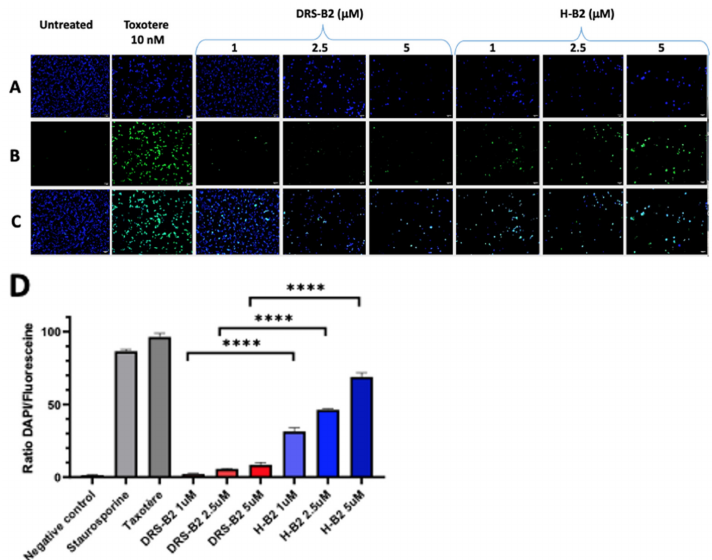
Figure 10. Terminal transferase-mediated dUTP nick end-labeling (TUNEL) in vitro assay of treated PC3 cells. Apoptosis of PC3 cells using TUNEL assay in vitro after DRS-B2 and H-B2 treatment. Cells were treated for 24 h with increasing concentrations of each peptide. Taxotere treatment was performed as a positive control for apoptosis. ( A ) Cells were stained with DAPI. ( B ) 3 (cid:48) Hydroxyl- nucleotides of double strand DNA breaks were stained with Fluoresceine. ( C ) Merged fluorescence of DAPI and fluoresceine showing DNA fragmented cells. ( D ) Histogram representing percentage of fragmented DNA-containing cells of the total number of cells. n = 3 (Mean ± SD; **** p <